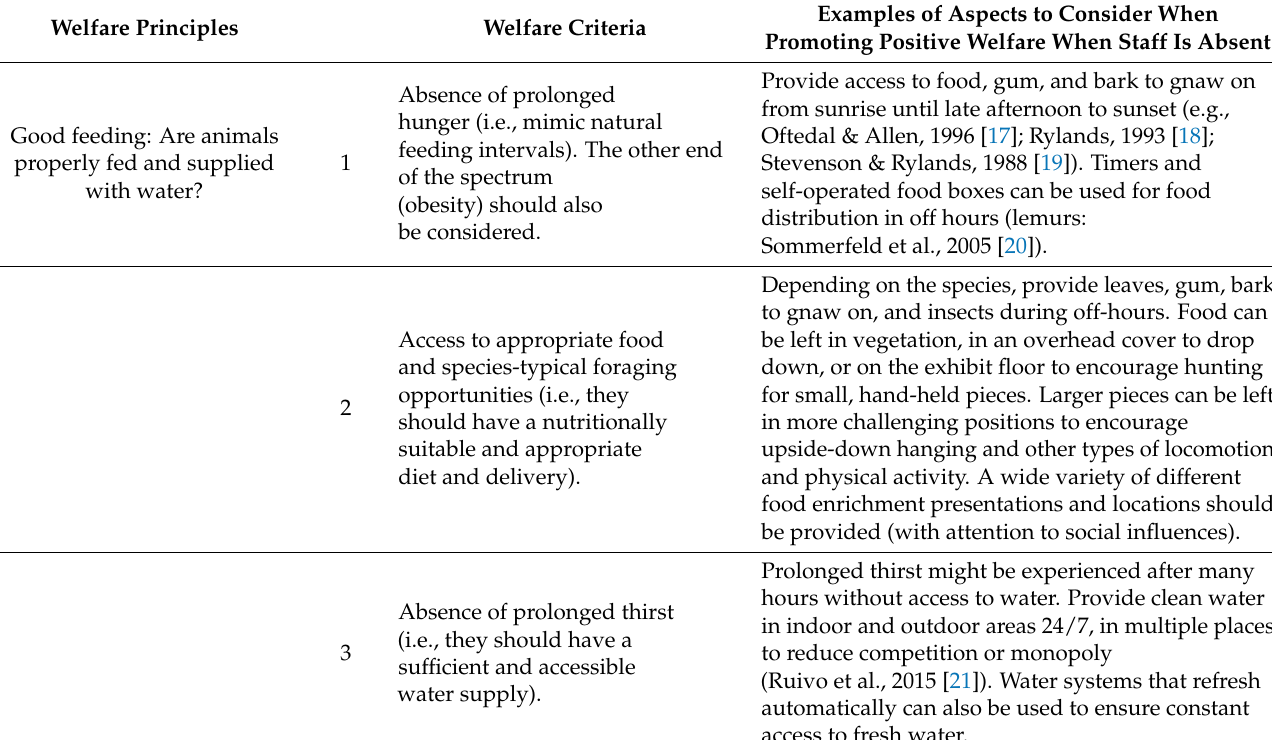
Table 1. This table highlights 14 welfare criteria with examples of what to consider when promoting primate welfare when staff is absent. Adapted from Brando and Buchanan-Smith 2018; the first two columns are directly from this paper, with our commentary in the third column. Welfare Principles Welfare